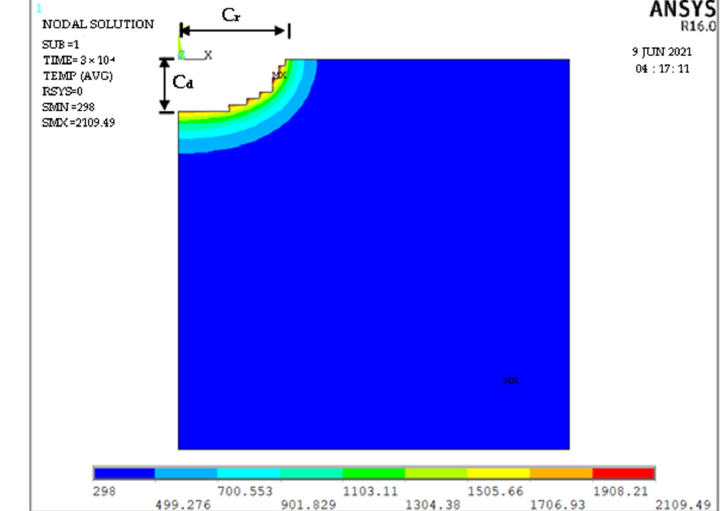
Figure 4. Typical voltage and current pulse train acquired for discharge duration 300  s, peak cur- rent 6A and gap voltage 80 V (--- Threshold value).